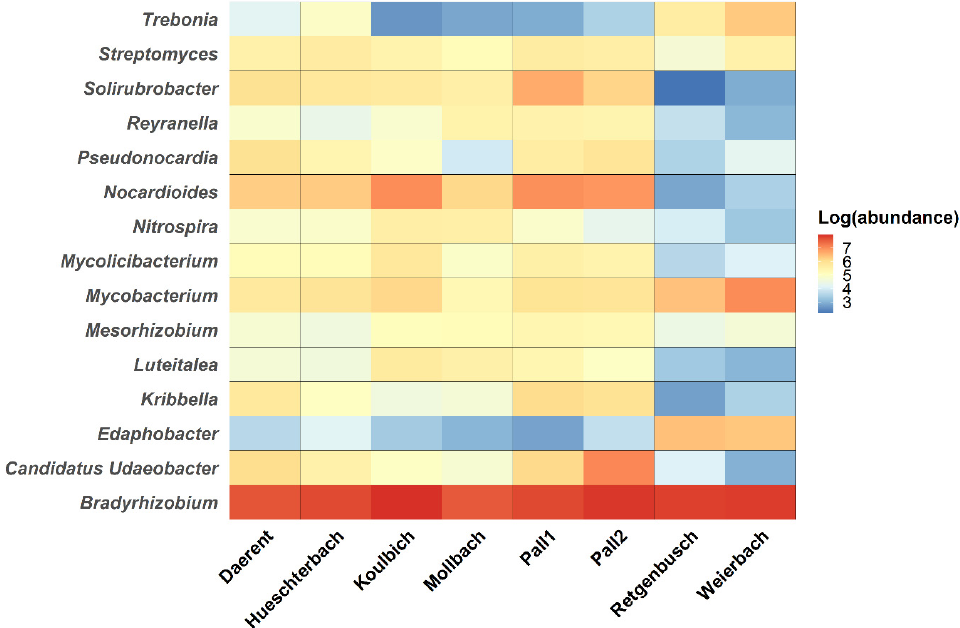
Figure 5. Heatmap of the most occurrent bacterial genera identified (selection with a log-abundance above 3) as a function of the sites. The gradient represents the log-transformed abundance of the genera, where red colour represents the most abundant genera and blue, the least ones.